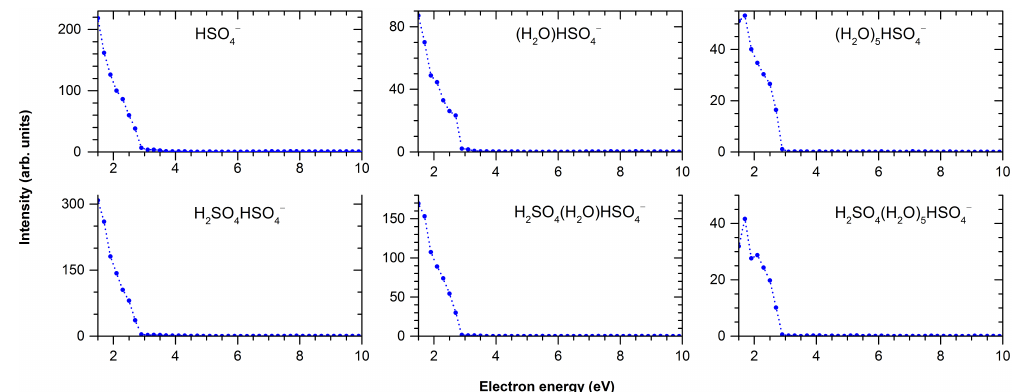
dissociation channels 4